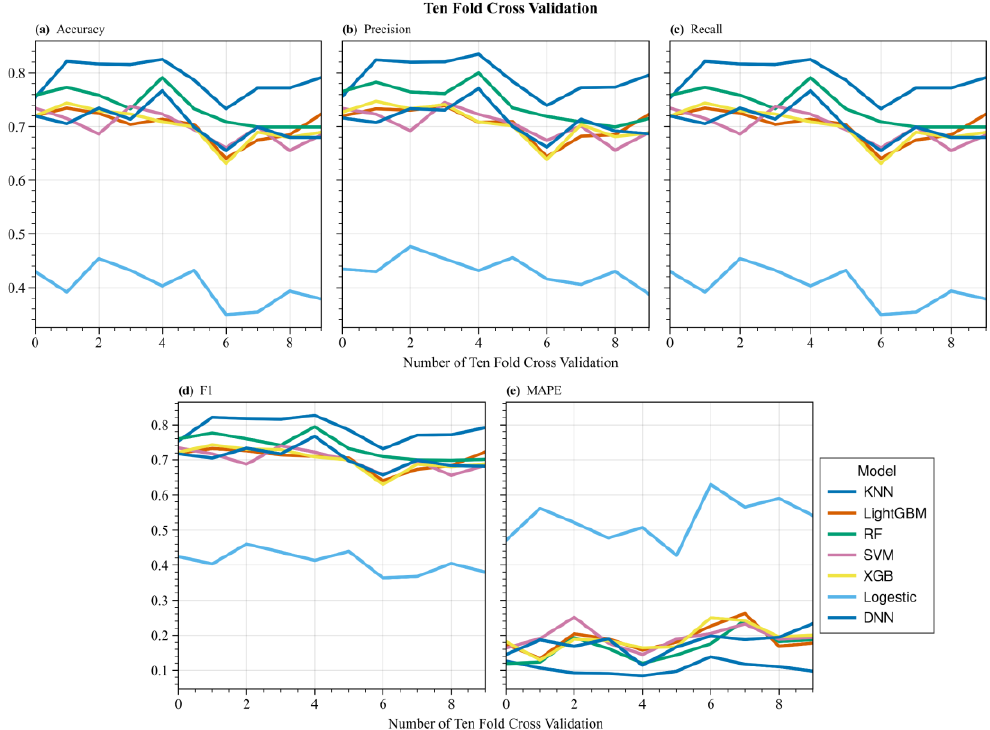
Figure 5. The results of Ten-Folder Cross Validation from panel ( a ) to panel ( e ): Accuracy, Precidsion, Recall, F1, MAPE.